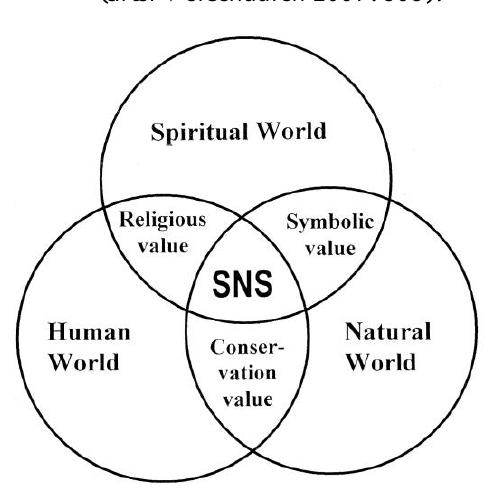
Fig. 4. Main constituent values of Sacred Natural Sites,